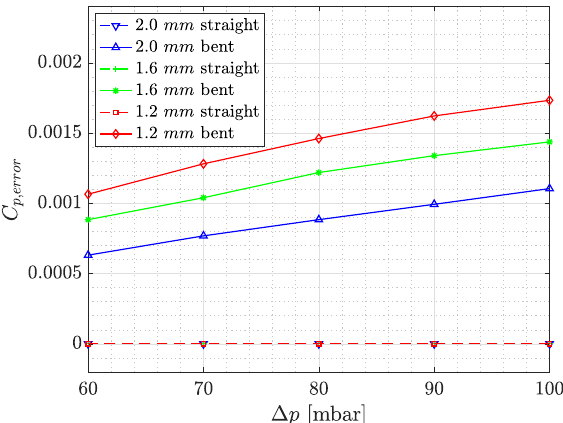
Figure 4. C p , error against the pressure difference ∆ p for a straight and bent pressure tap for different wall